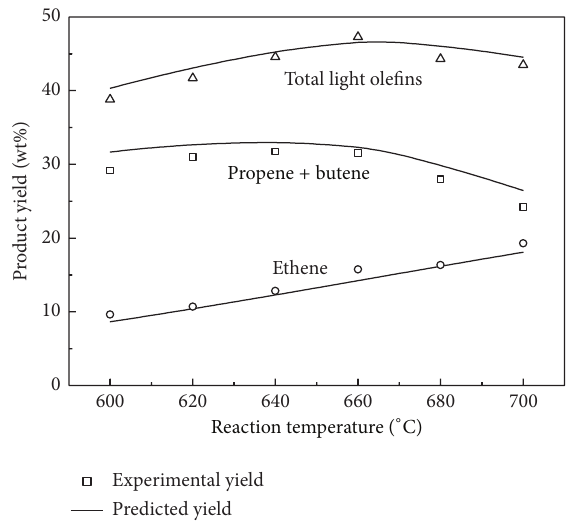
Figure 4: Predicted and experimental light olefin yields as a func- tion of reaction temperature (catalytic pyrolysis of HAGO, catalyst- to-oil weight ratio of 16.7, weight hourly space velocity of 4.87 h −1 , and steam-to-oil weight ratio of